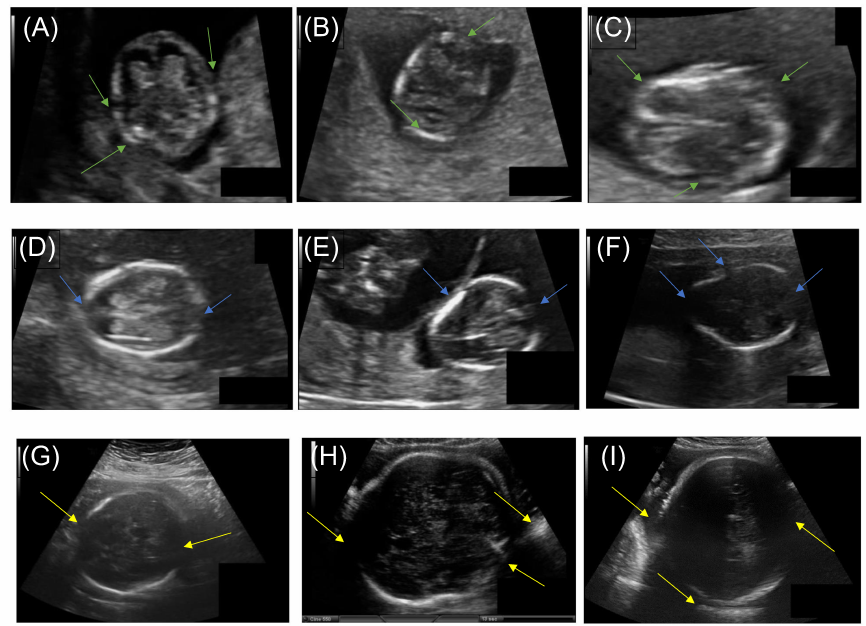
Figure 1. Typical prenatal ultrasound images from each trimester. ( A – C ) First trimester, green arrows indicate blurred fetal head and artifacts. ( D – F ) Second trimester, blue arrows indicate poor signal- to-noise ratio and reflection from the fetal membranes and amniotic fluid interface. ( G – I ) Third trimester, yellow arrows indicate speckle noise and standard sutures or ultrasonography